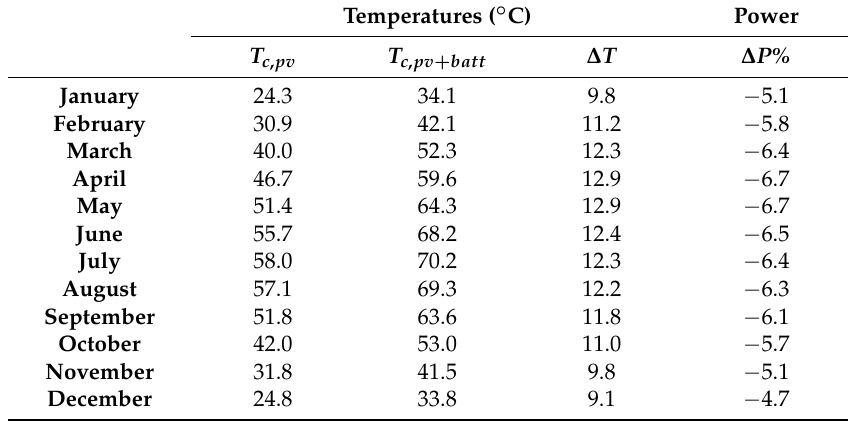
Table 4. PV cell temperatures obtained by thermal models in the case of PV conversion ( P pv (cid:54) = 0, η = 12%) and corresponding percentage decrease of electric power. Temperatures ( ◦ C) Power T c , pv T c , pv + batt ∆ T ∆